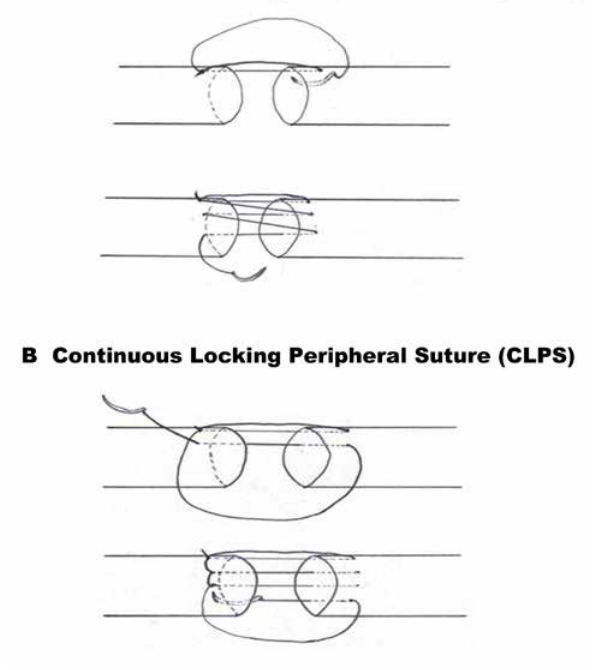
Figure 1: Illustrations of continuous running peripheral suture (CRPS) (A) and continuous locking peripheral suture (CLPS)